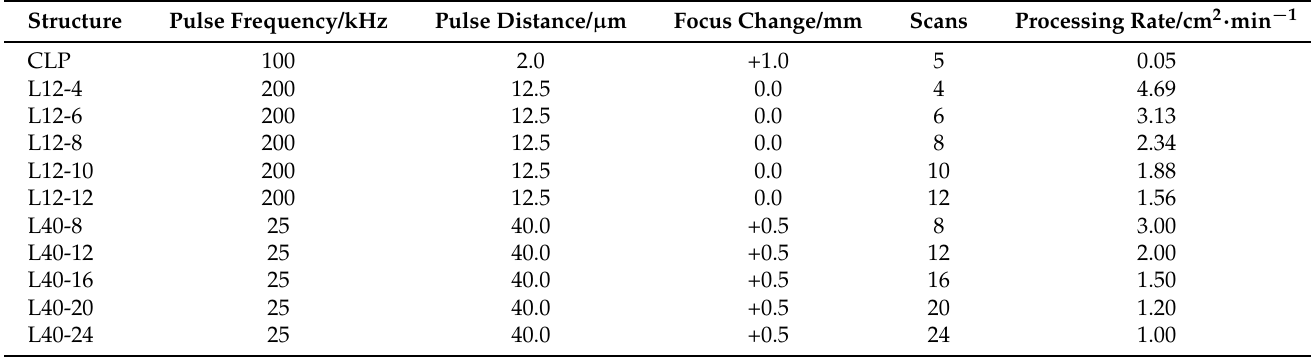
Table 3. Used processing parameters for the laser structuring